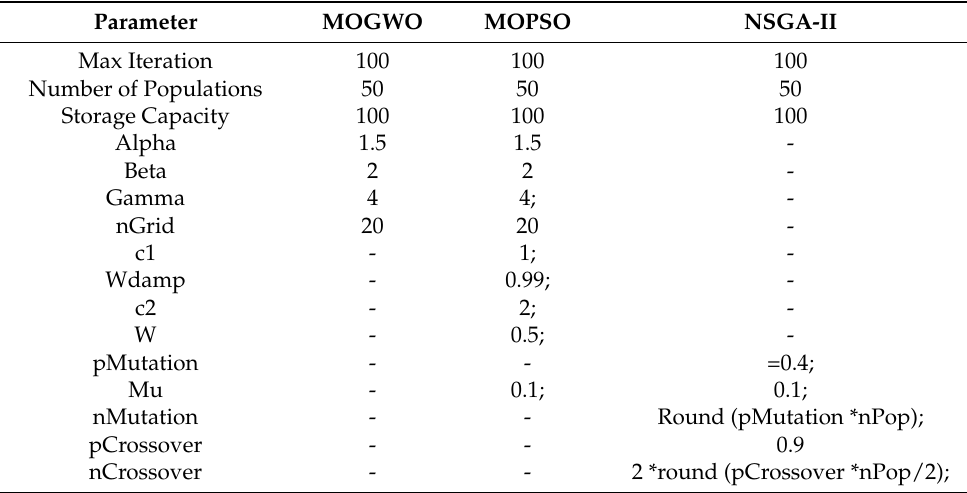
Table 3. Parameter setting of the three multi-objective